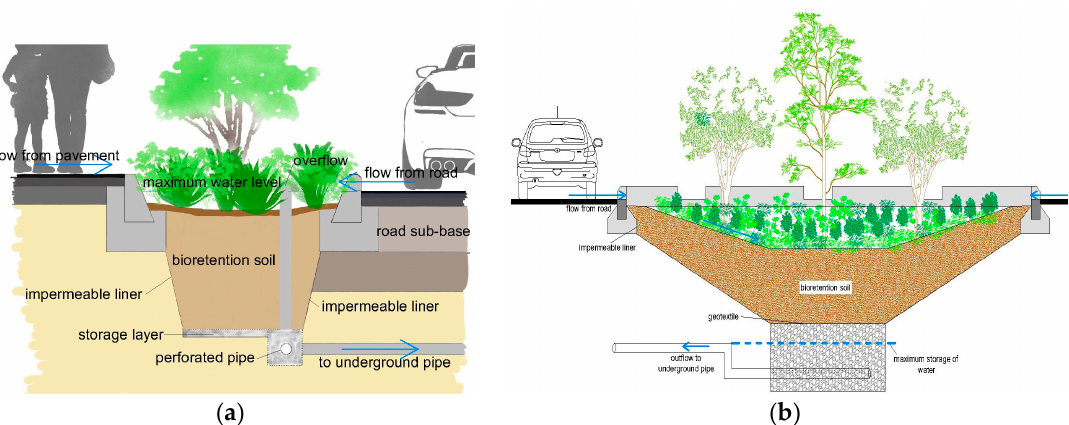
Figure 4. ( a ) Sketch of a street scape bioretention system. It is usually placed in main roads with no parking allowance. In case of the presence of a parking lane, a pavement of about 0.60 m should be installed between the system and the road; ( b ) conceptual sketch of a bioretention system in a